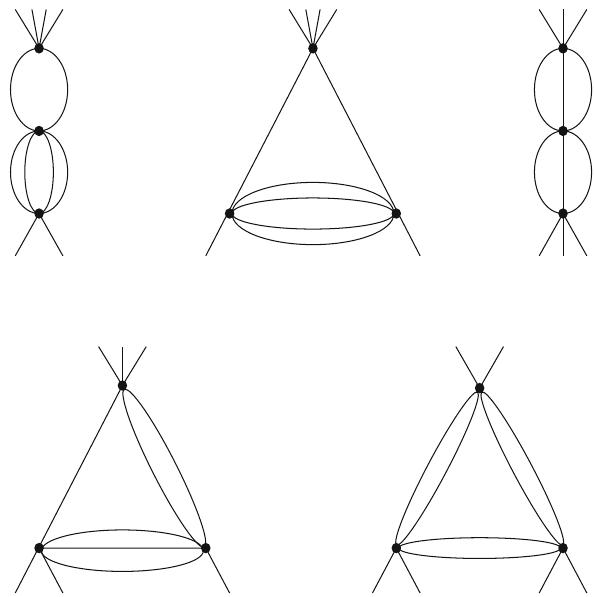
Fig. 6 Next to leading order topologies for 6-point function in φ 6 the-